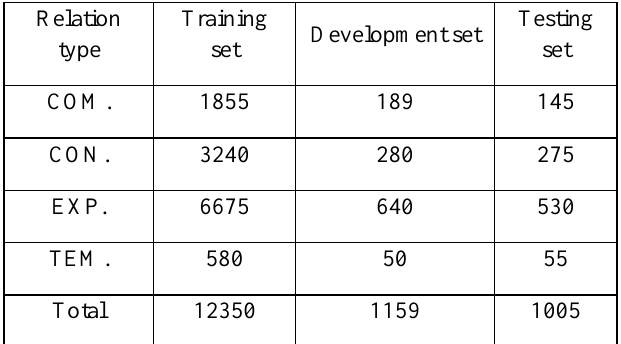
Table 1. PDTB data distribution of four kinds